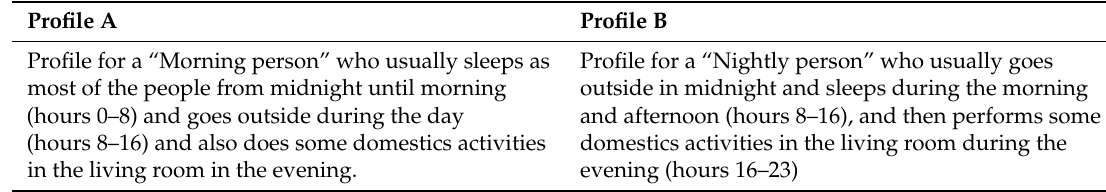
Table 5. Users Profiles—Synthetic dataset.